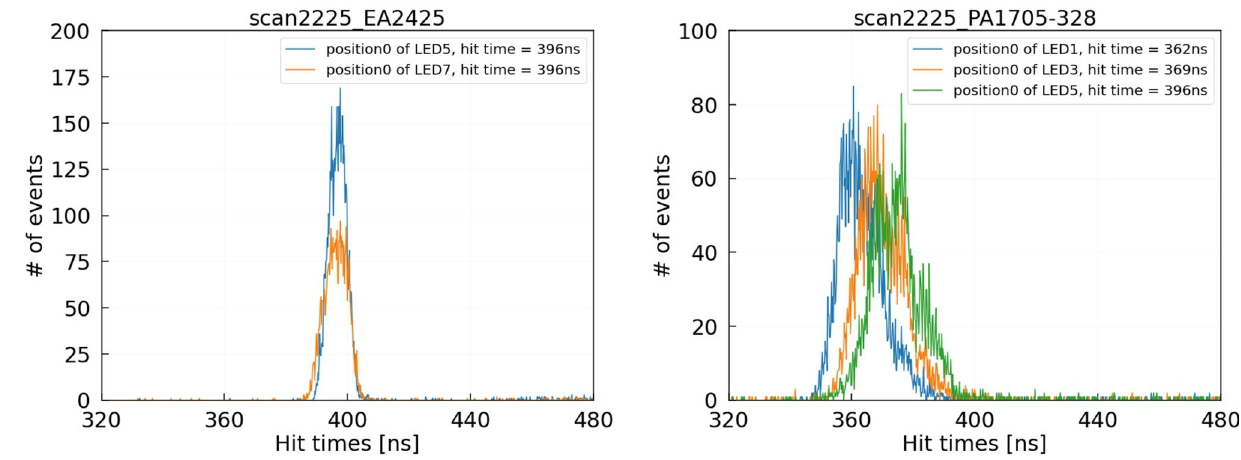
Fig. 40 PMT hit time (relative TT) distribution of a single NNVT and HPK PMT directly measured in the scanning station with different LEDs (locations) at azimuthal angle φ = 0. Left: HPK (blue: 5th LED; orange: 7th LED); right: NNVT (blue: 1st LED; orange: 3rd LED; green: 5th LED)